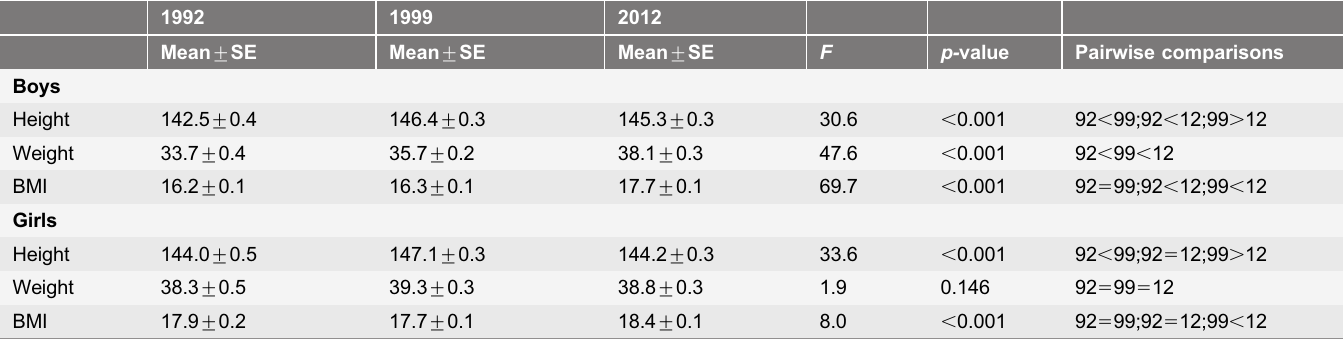
Table 3. Age and biological maturation-adjusted means ¡ standard errors for height, weight and BMI in boys and girls (8–15 years) by year of evaluation, and results of pairwise comparisons.